Question: Provide a one-line summary of what is displayed.
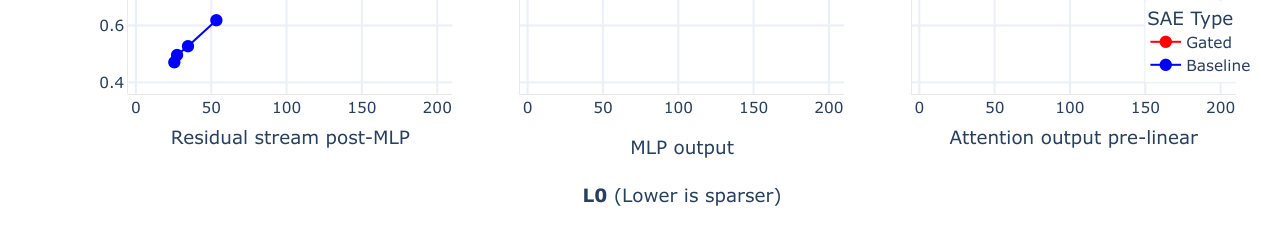
Answer: | Gated and Normal Pareto-Optimal SAEs for Gemma-7B – see Appendix B for a discussion of the anomalies (such as the Layer 27 attention output SAEs), and Table 1-4 for full stats (including points not on the Pareto frontier).